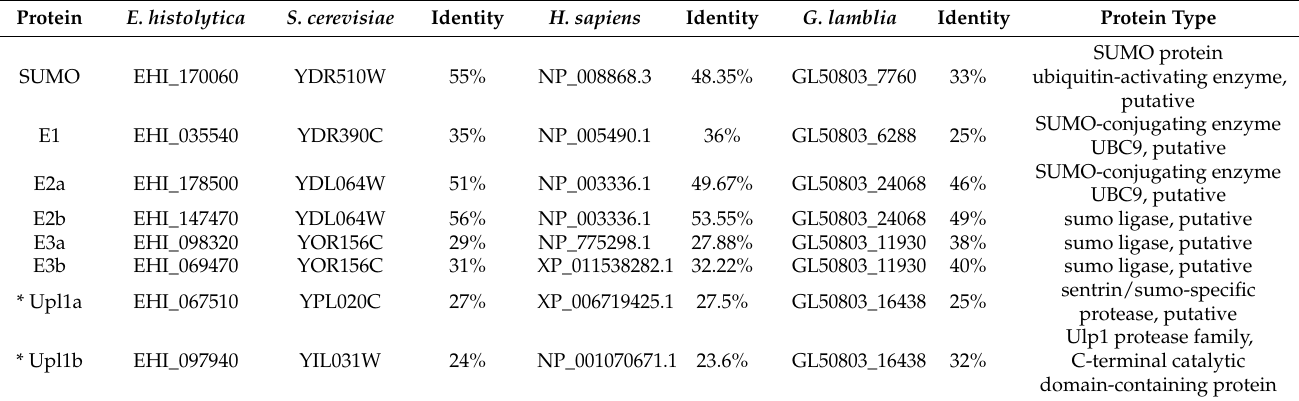
Table 2. Comparison of putative proteins involved in SUMOylation in E. histolytica , S. cerevisiae , H. sapiens , and G. lamblia . Protein